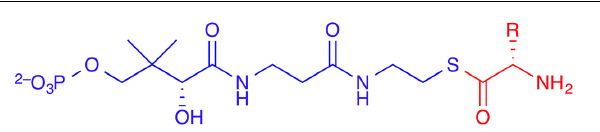
FIGURE 6 | The (amino-acid) substrate (shown in red) of non-haem iron/2-oxoglutarate dependent halogenases is linked as a thioester to a phosphopantetheine (PPant) tether (in blue) and presented to the enzyme by a carrier protein.